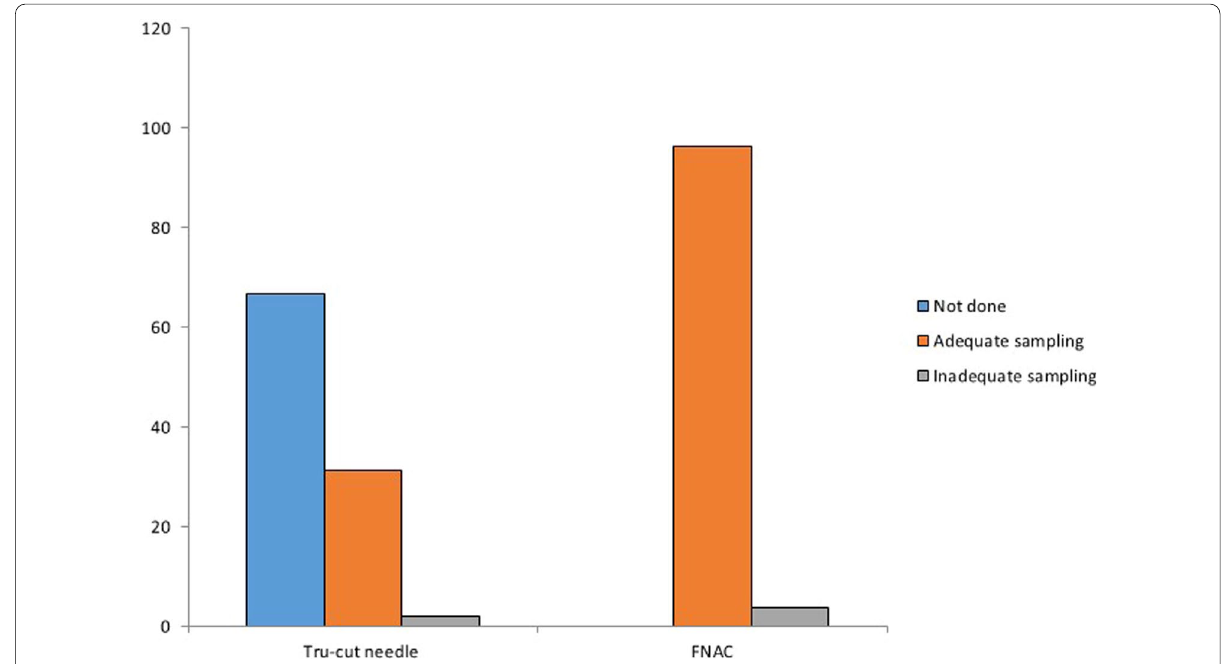
Fig. 1 Sampling adequacy of FNAC and Tru‑cut needle biopsy